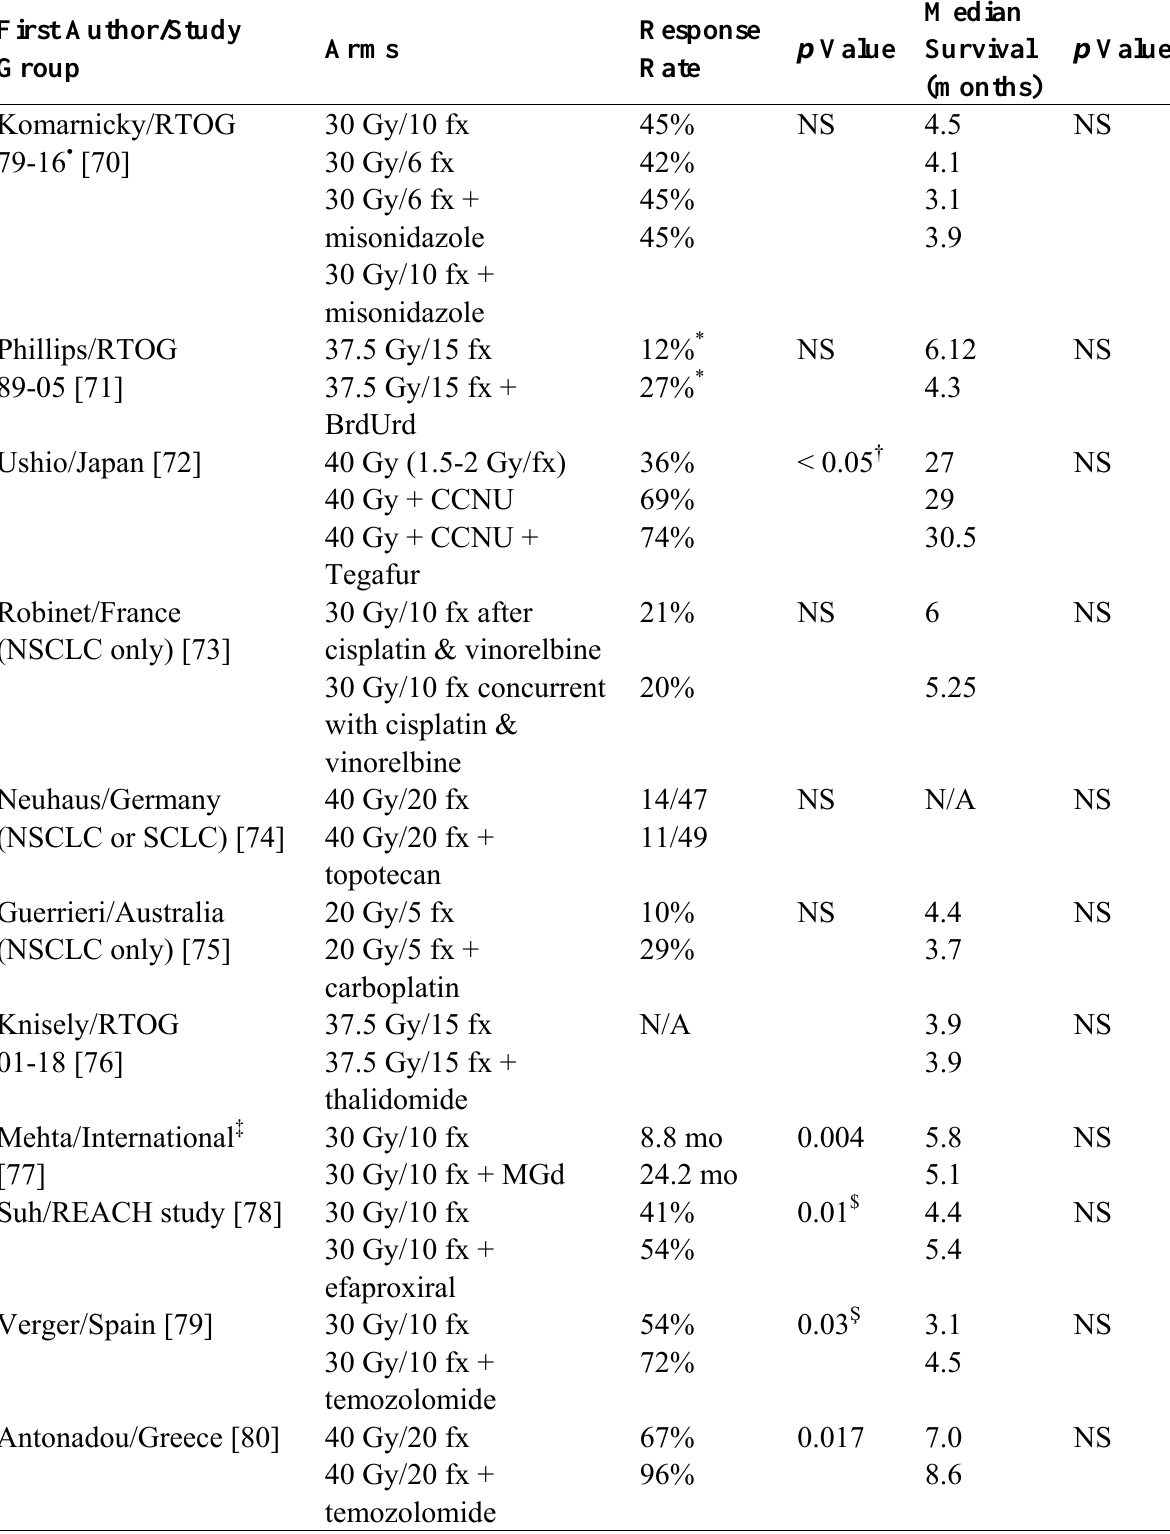
Table 6. Selected randomized studies on radiosensitizers for multiple brain